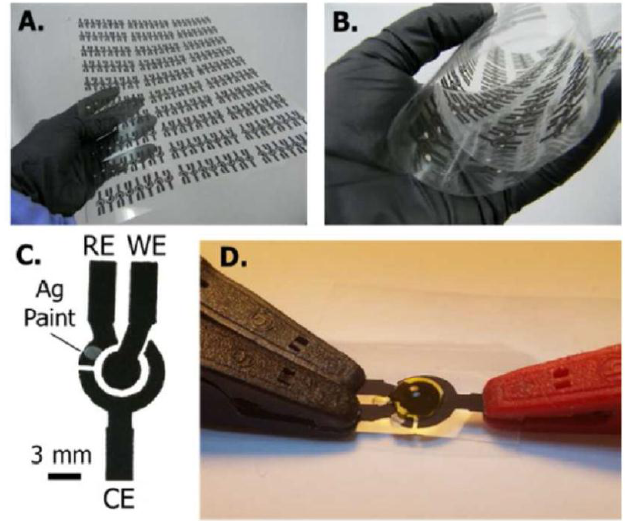
Figure 6. Reprinted from [116] with permission from ACS. Stencil printed carbon electrodes on transparency film shown as a ( A ) printed sheet that is ( B ) flexible. ( C ) A single printed electrode image showing carbon working (WE), silver paint reference (RE), and carbon counter (CE) electrode geometries and connections. ( D ) Final device image with 30 µL of solution contained within the central well and connected to potentiostat leads.